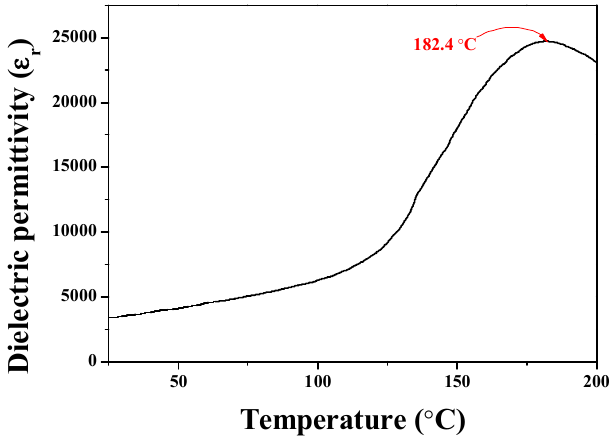
Figure 5. Temperature-dependent dielectric constant of the 0.675PbMgNbO 3 -0.325PbTiO 3. ceramics and Curie temperature. Table 1. Characteristics of the prepared PMN-PT.